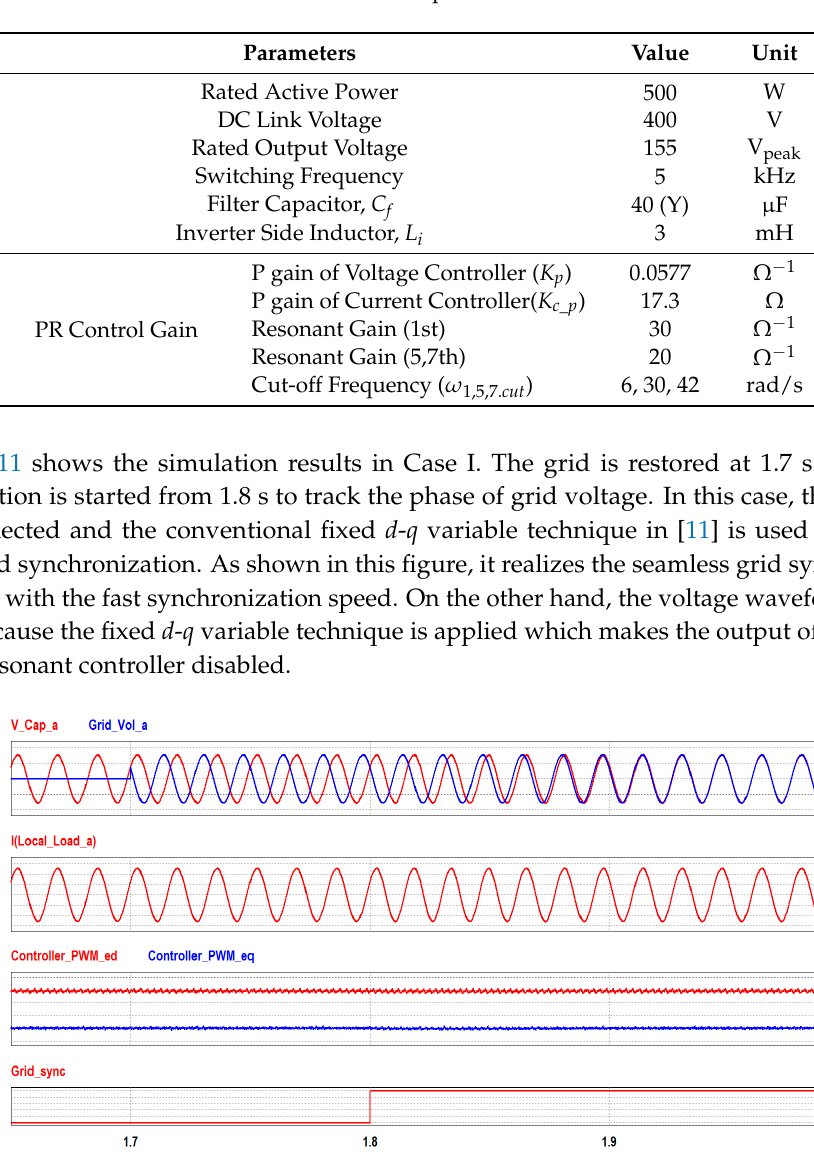
Table 1. Simulation and Experimental Parameters.